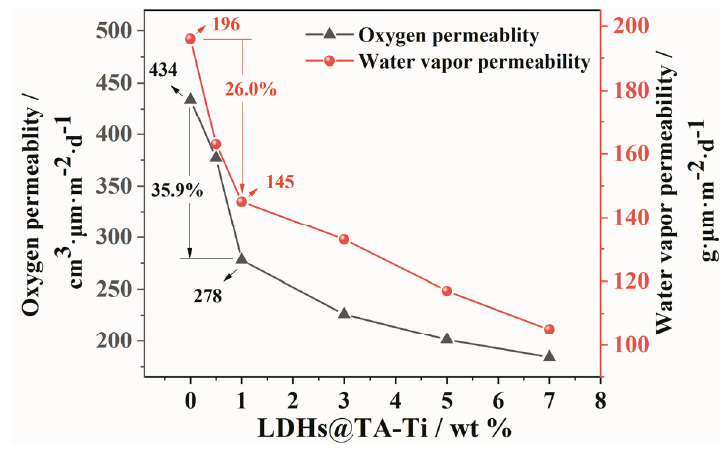
Figure 11. Oxygen permeability and water vapor permeability of LDHs@TA-Ti/PVA nanocomposites .